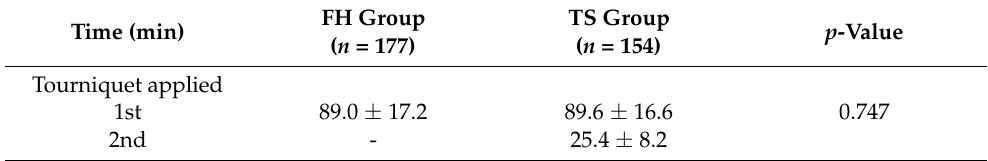
Table 8. Durations of tourniquet applications. Time